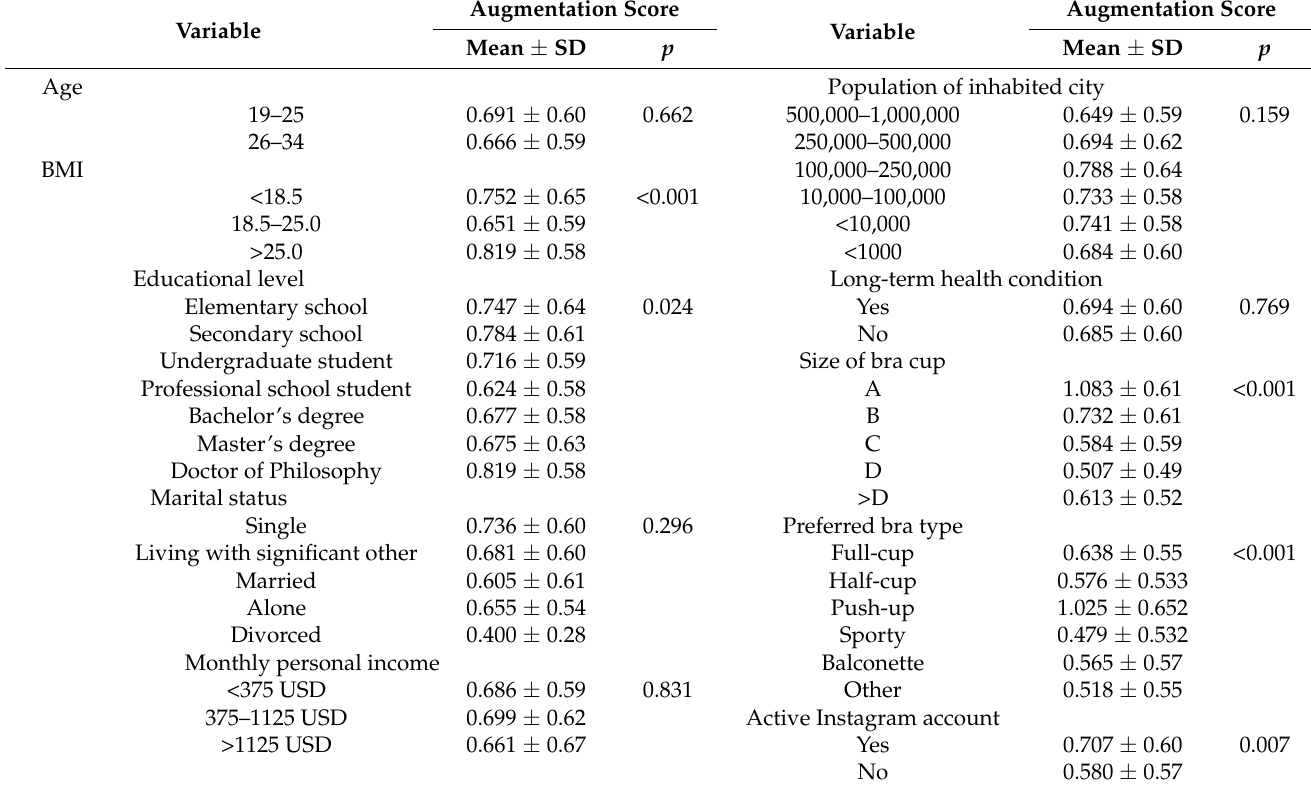
Table 1. Univariate analysis of associations between augmentation scores and demographic